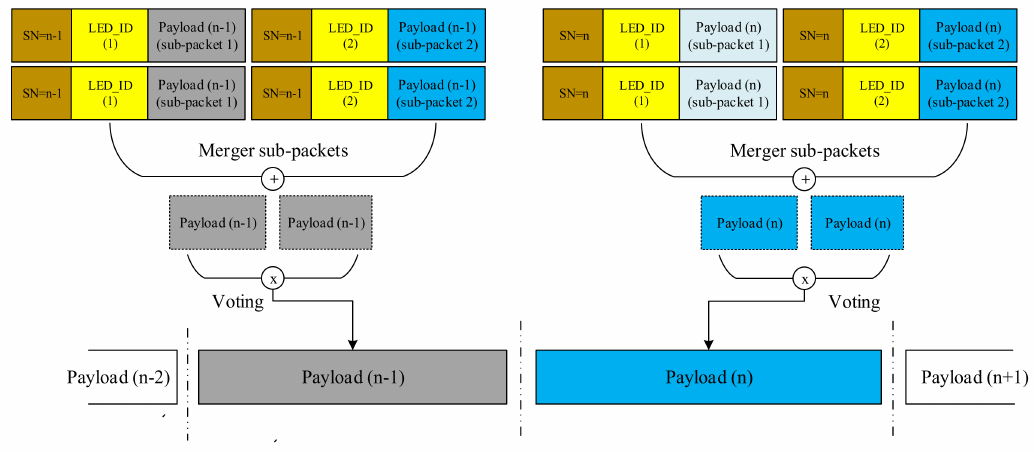
Figure 13. Merging procedure of MIMO COOK scheme in the time